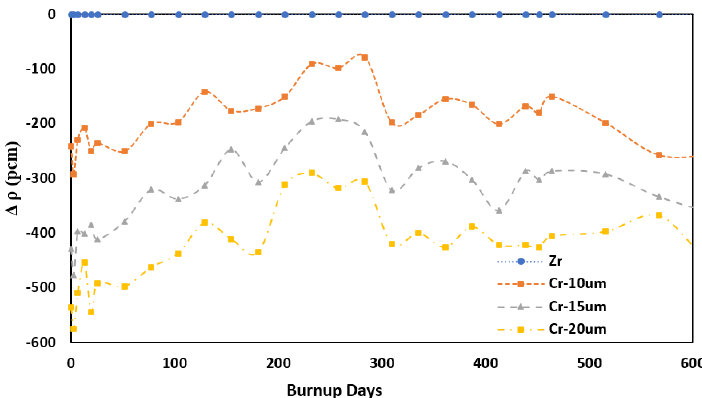
Figure 11. Effective multiplication factor comparison versus burnup days for APR-1400 reactor core.